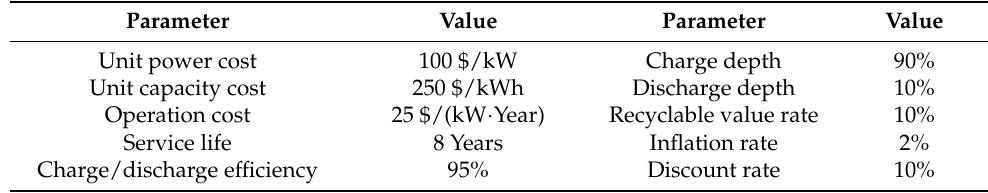
Table 5. Parameters of the